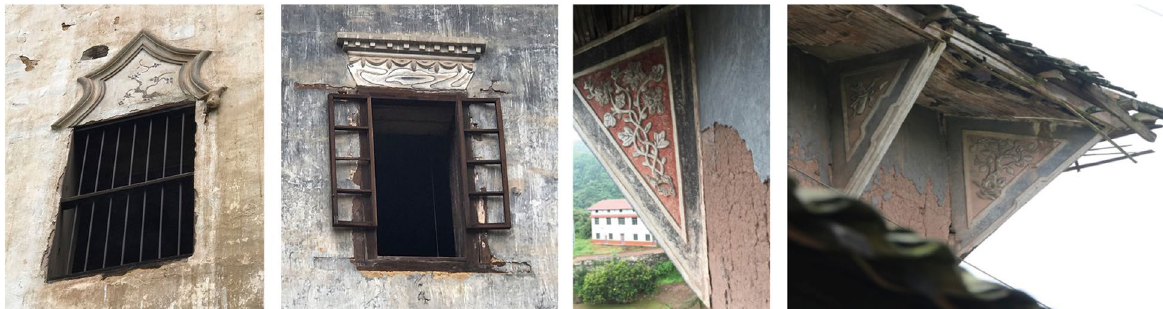
Fig. 11 Small window decoration with different shapes of rammed earth watchtowers in Ba ′ nan and Jiangjin, Chongqing (Source: the